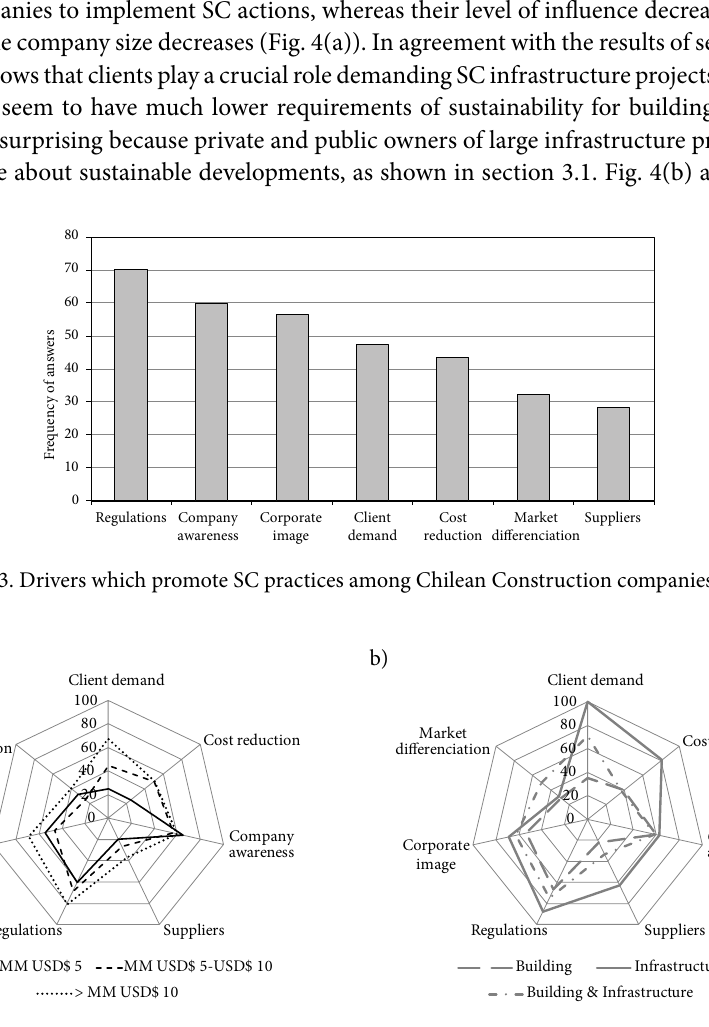
Fig. 4. Drivers of change grouped by two factors: a) companies’ annual gross revenue, b) companies’ core